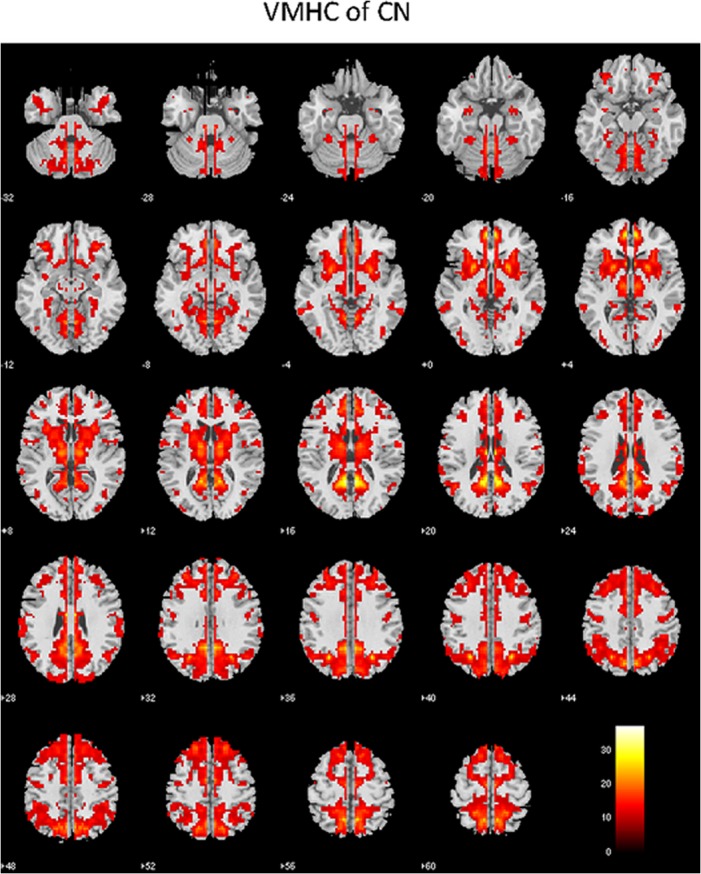
Normative VMHC map of the CN group (one-sample t-test, family-wise error corrected, p < 0.001, extent threshold = 10).